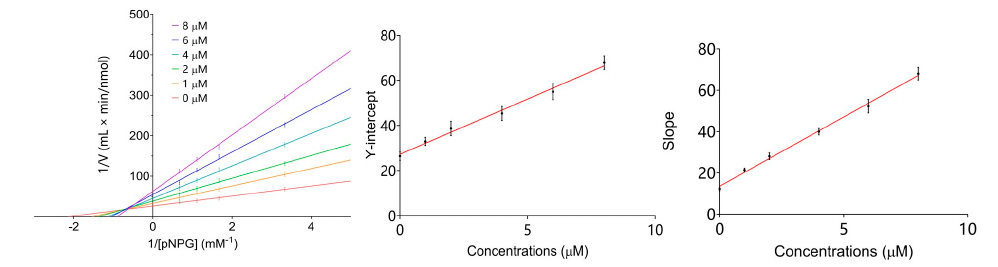
Figure 4. Lineweaver-Burk plots of compound 7.